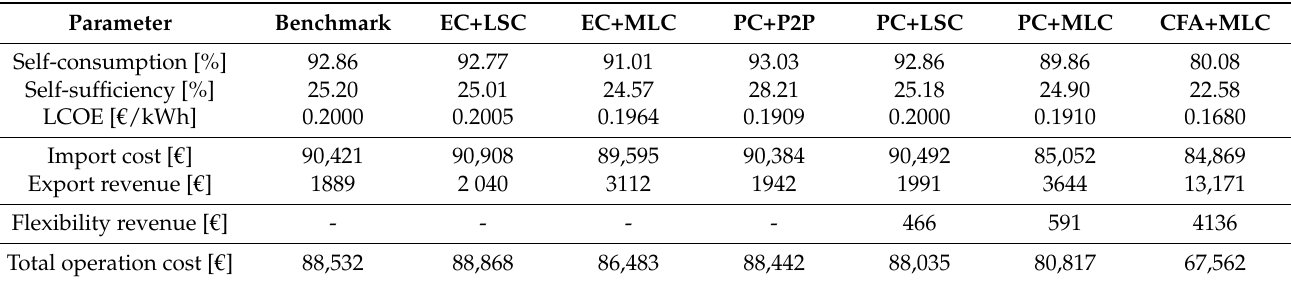
Figure 6. Differences between scenario simulation results (compared to benchmark) with different Nord Pool Spot market data. Simulation results with 2021 and 2022 Nord Pool Spot market prices are compared. Self-consumption, self-sufficiency: negative values show better performance with 2021 Nord Pool Spot market prices than with 2022 prices and vice versa; LCOE, Total operation cost: positive values show better performance with 2021 Nord Pool Spot market prices than with 2022 prices and vice versa. Table 5. Summary of simulation results with 2022 Nord Pool Spot